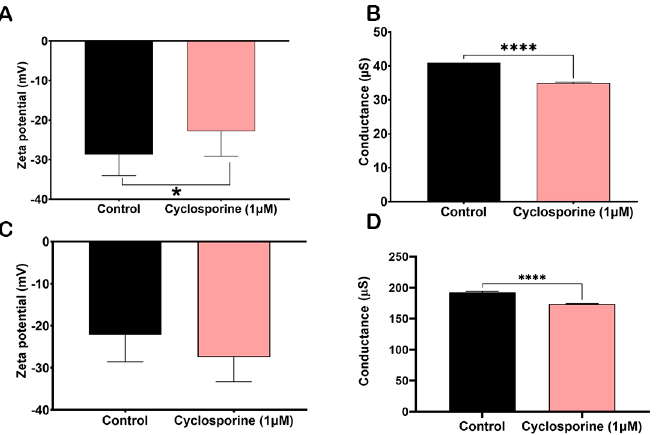
Figure 6. Effect of cyclosporine on zeta potential ( A ) and conductance ( B ) of C. neoformans cells. * p - value = 0.03 and **** p -value < 0.001; statistical significance determined by t test. Effect of cyclosporine on the zeta potential ( C ) and conductance ( D ) of PSs from C. neoformans . **** p -value < 0.001; statistical significance determined using Student’s t test.